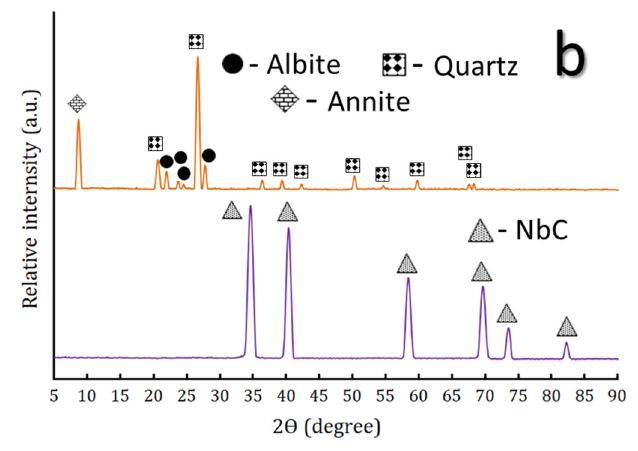
Figure 2. The XRD patterns of ( a ) as-received Fe waste after milling and Cu powders, and ( b ) as-received NbC and granite powders.